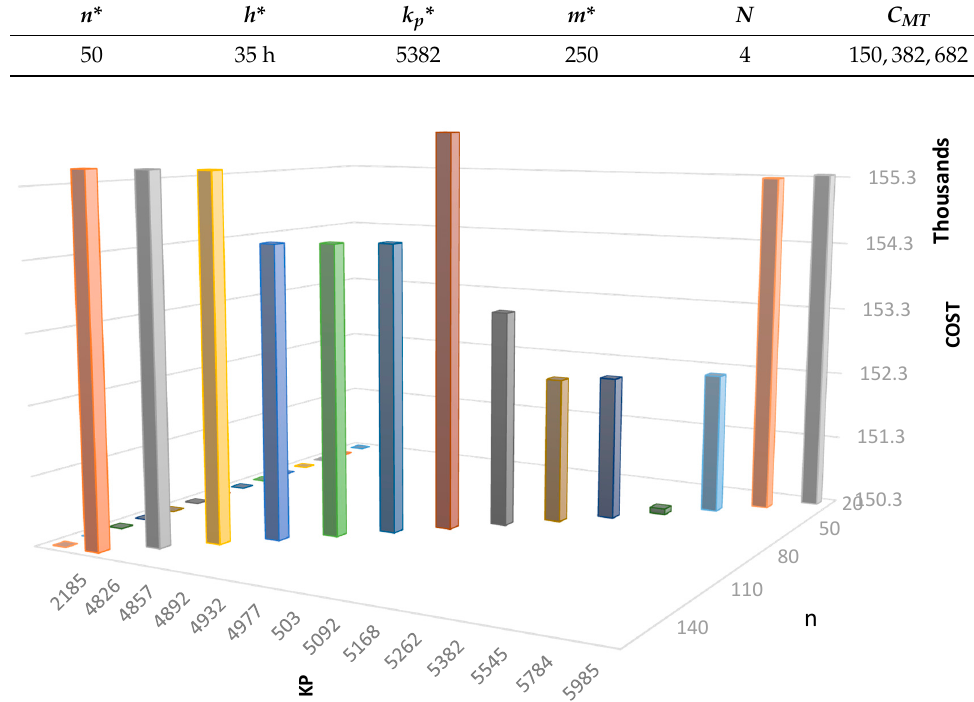
Figure 9. Total cost according of sample size ( n ) and the coefficient of control chart ( kp ).